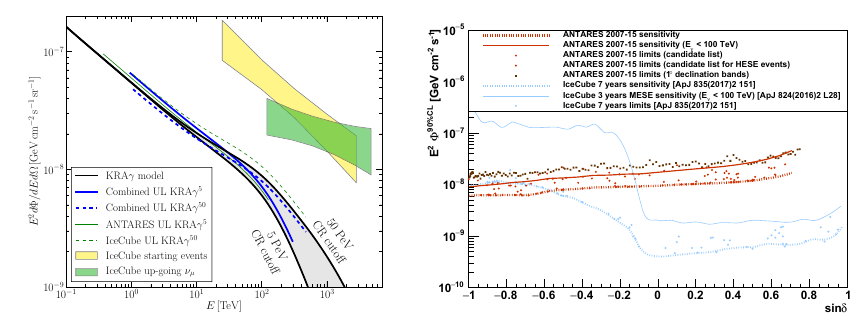
Figure 2. Distribution of the energy estimator for track-like (left panel) and shower-like (middle panel) events, after the event selection chain. The solid (dashed) red histogram shows the cosmic neutrino expectation for a cosmic flux proportional to E − 2 (E − 2 . 5 ) with normalization Φ 1 f (100 TeV) = 10 − 18 0 (1.5 10 − 18 )GeV − 1 cm − 2 s − 1 sr − 1 . The blue line represents the sum of all atmospheric events. The gray × line represents the energy-related cut. Data after unblinding are shown as black crosses. Right: 2D Figure 3. Left: Combined upper limits (UL) at 90% C. L. (blue lines) on all-flavor neutrino flux of log-likelihood scan of the di ff use cosmic flux normalization and spectral index obtained in the latest the KRA γ model with the 5 and 50 PeV cuto ff s (black lines), see Ref [13] for explanations. The boxes Antares search for a di ff use flux. represent the di ff use astrophysical neutrino fluxes measured by IceCube using an isotropic flux template with starting events (yellow) and upgoing tracks (green). Right: Sensitivities (lines) and upper limits at 90% C.L. (red circles) on one-flavor from the investigated candidates assuming an E − 2